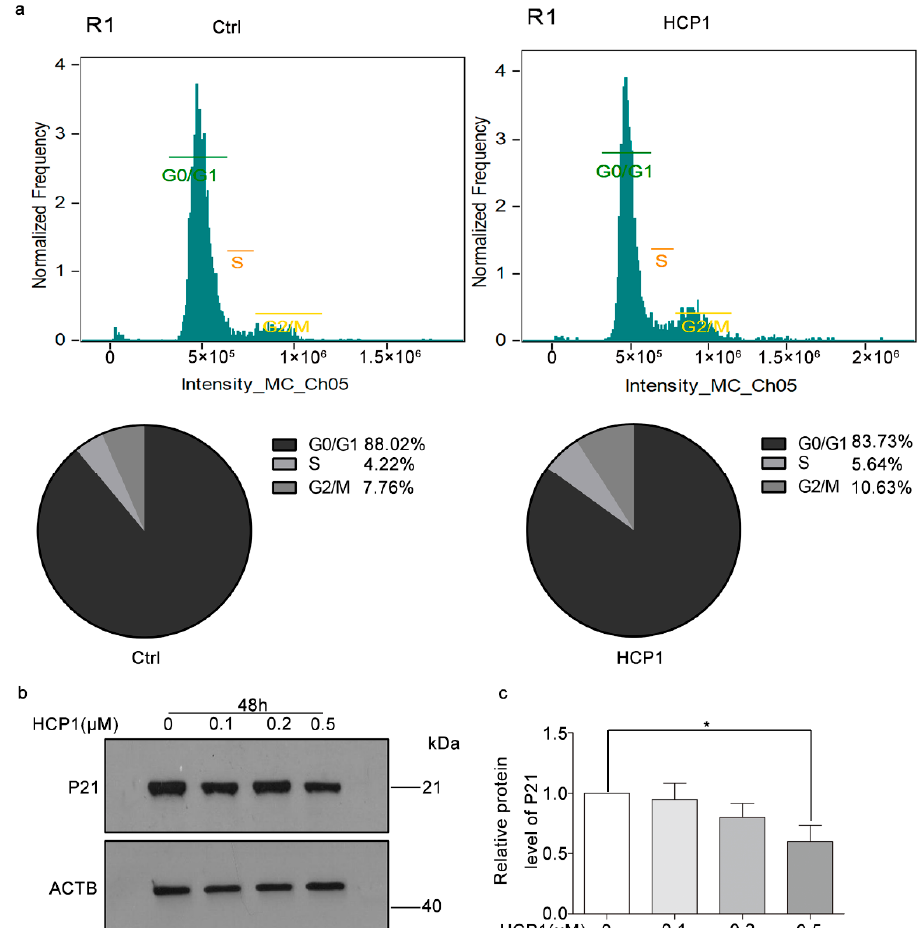
Figure 2. HCP1 regulated cell cycle in senescent HDFs. ( a ) Senescent HDFs were treated with DMSO or HCP1 (0.5 µ M) for 48 h, the proliferation of senescent HCP1 was analyzed by flow cytometry. ( b , c ) HCP1 (0, 0.1, 0.2, 0.5 µ M) treated senescent HDFs for 48 h, Western blot was used to detect the protein level of P21. Data are presented as means ± SEM, * p < 0.05, n = 3.3. HCP1 Improved the Protein Level of Type I Collagen and Senescence-Associated Heterochromatin Foci (SAHF).